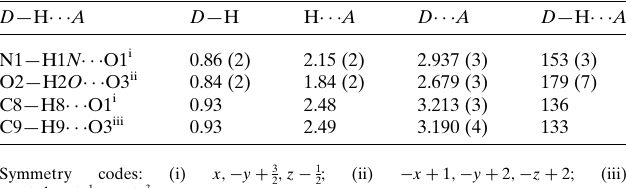
Table 1 Hydrogen-bond geometry (A˚ , (cid:2) ).